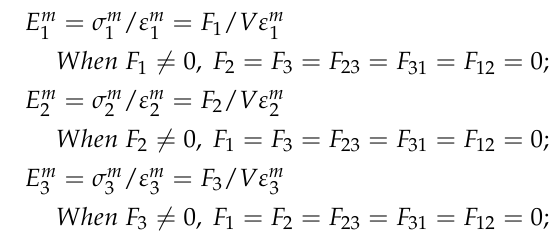
In Figure 3, n j is the unit vector perpendicular to the S σ boundary, t The key to realize the homogenization is to obtain the equivalent stiffness of the composite. For the periodic continuum structure, the uniform displacement boundary Figure 3. Boundary conditions for heterogeneous material M in R domain. Figure 3. Boundary conditions for heterogeneous material M in R